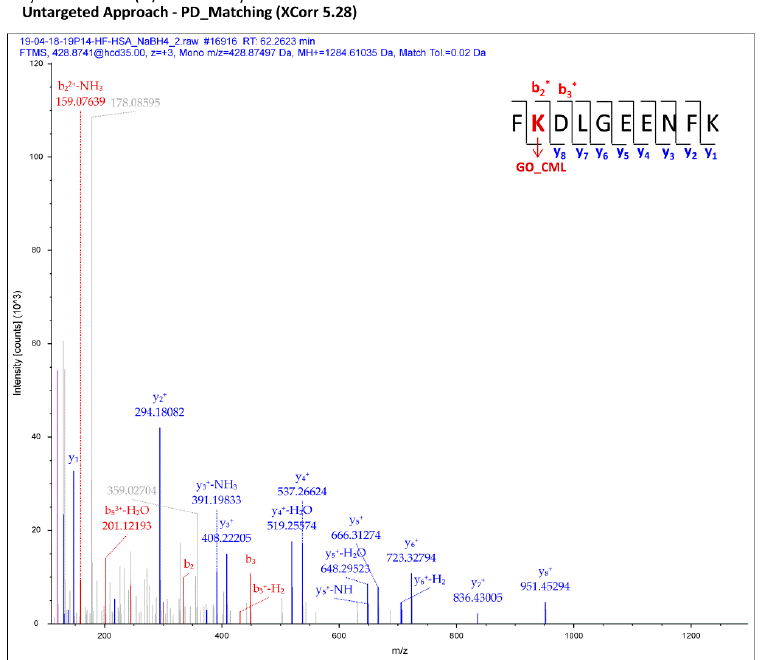
Figure 2. Fragmentation spectra related to a carboxymethyl-Lys adduct (CM-Lys 12) identified through the computational analysis (Proteome Discoverer) and confirmed by manual check. (*modified fragment